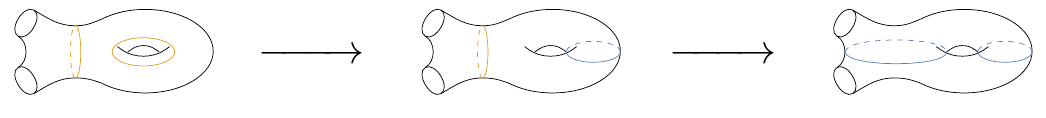
Figure 2 . Example of a crossing transformation on the torus two-point